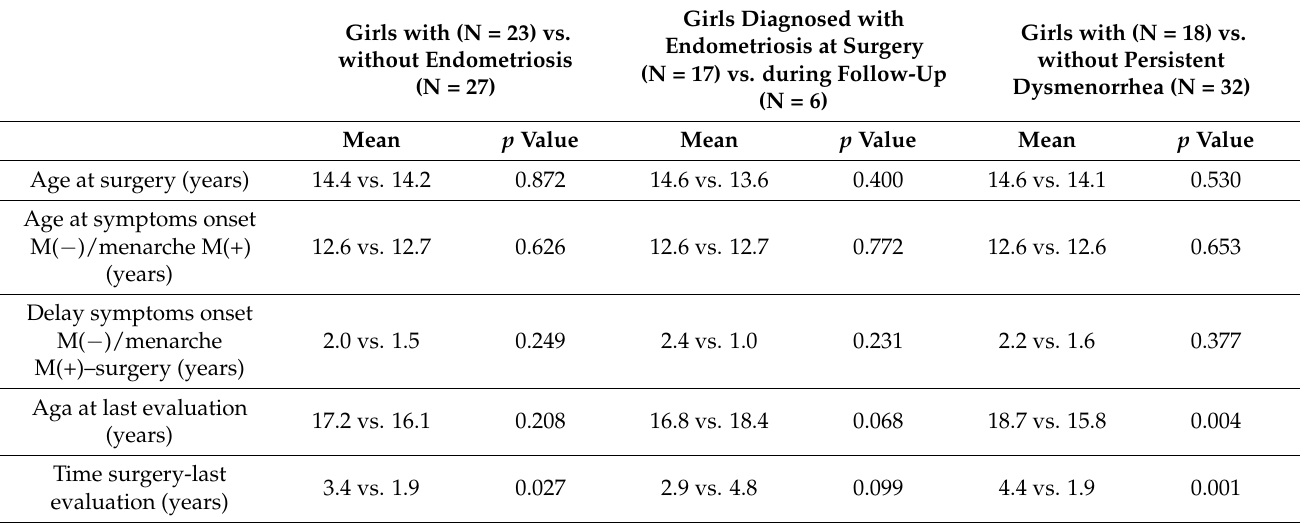
Table 5. Comparison of subgroups of the subjects. N: number; M( − )—in adolescents with cryp- tomenorrhea; and M(+)—in adolescents with menses. Girls Diagnosed with Girls with (N = 18) vs. Girls with (N = 23) vs. Endometriosis at Surgery without Persistent without Endometriosis (N = 17) vs. during Follow-Up Dysmenorrhea (N = 32) (N = 27) (N = 6) Mean p Value Mean p Value Mean p